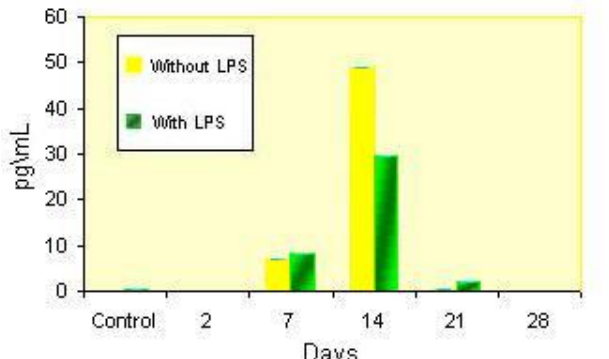
Figure 3. Levels of IL-6 produced by macrophages from BALB/c mice in the absence or presence of LPS in 48h-incubation culture. Values were expressed as means±SD.